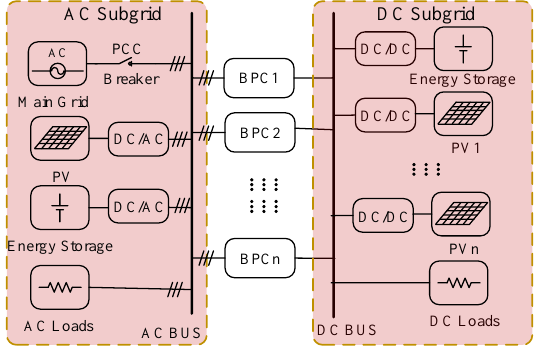
Figure 1. Hybrid microgrid topology with energy storages on both sides.